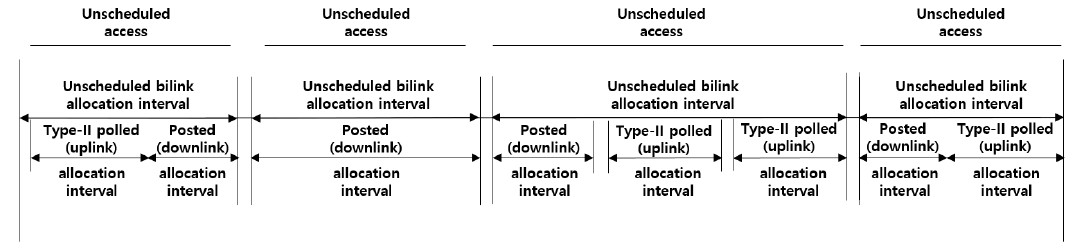
Figure 3. Non-beacon mode without